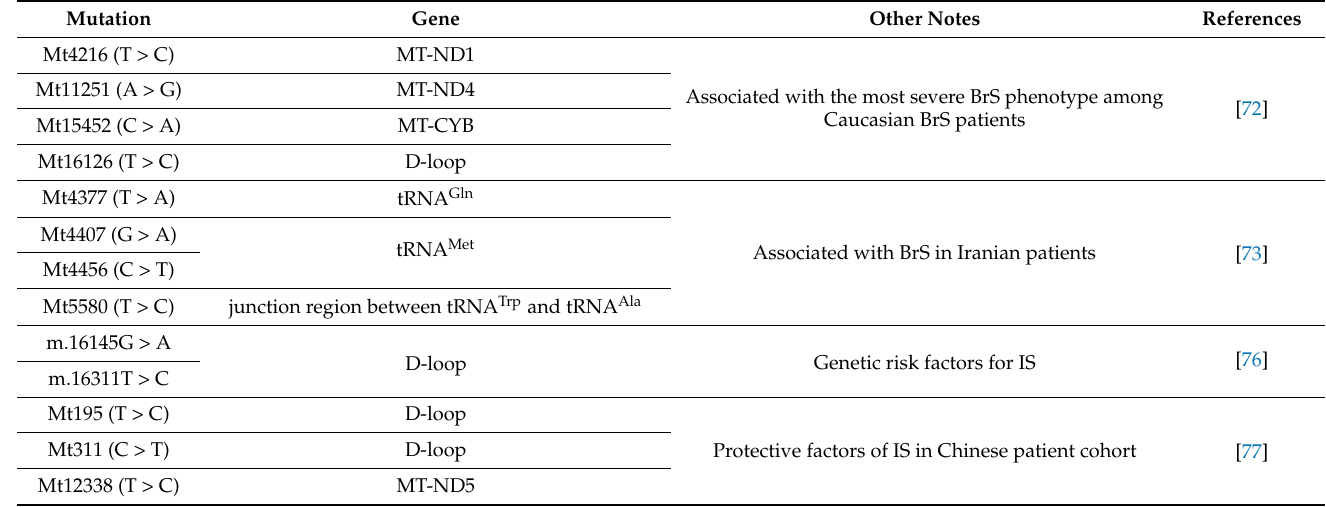
Table 3. List of mtDNA mutations associated with Brugada syndrome and ischemic